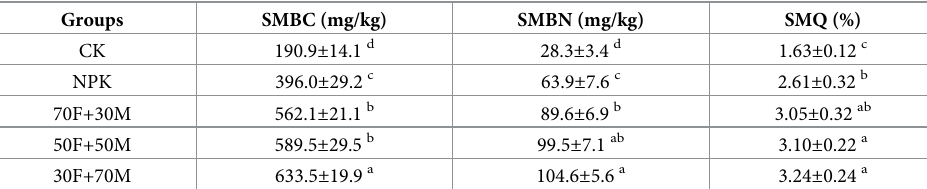
CK: non-fertilization group; NPK: balanced inorganic fertilization; 70F+30M: 70% chemical and 30% organic fertilizer group; 50F+50M: 50% chemical and 50% organic fertilizer group; 30F+70M: 30% chemical and 70% organic fertilizer group; SMBC: Soil microbial biomass carbon; SMBN: Soil microbial biomass nitrogen. SMQ: The soil microbial quotient. For all variables with the same letter, the difference between the means is not statistically significant ( p > 0.05). If two variables have different letters, they are significantly different ( p < 0.05).